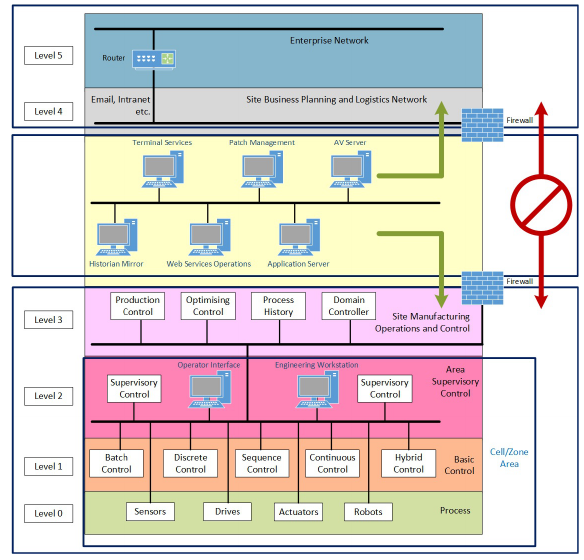
Figure 2. Purdue Model for Control